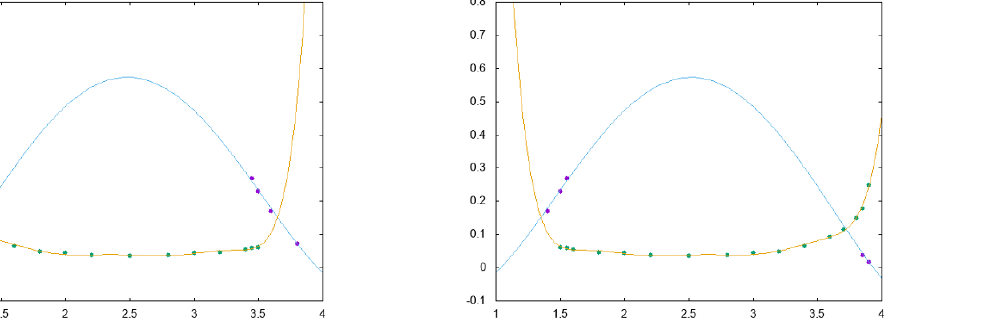
Figure 13 . The two boundary energies f 1 f 2 plotted vs. r , for k = 5 in the j = 3 blob s sector. The critical values of r c are the points of intersection of the two curves.